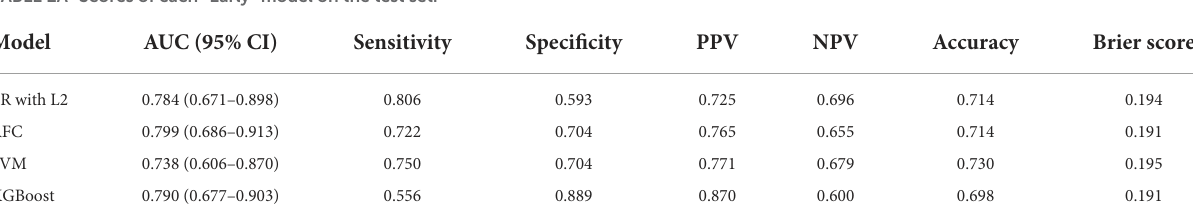
TABLE 2A Scores of each “Early” model on the test